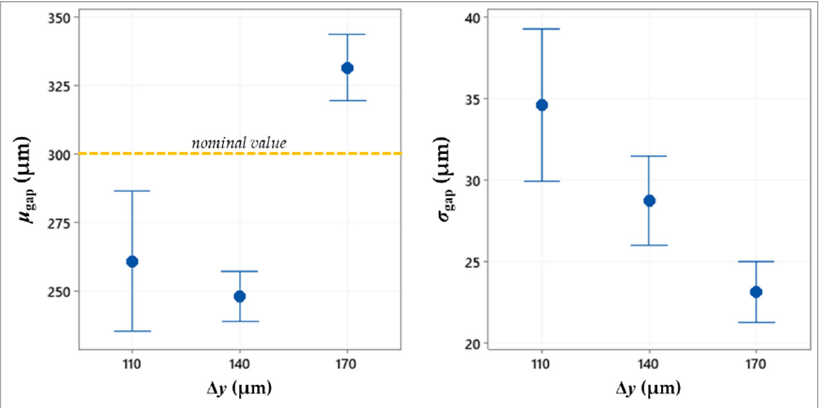
Figure 6. Interval plot of the mean value and standard deviation of the gap against drop spacing along the y-axis.